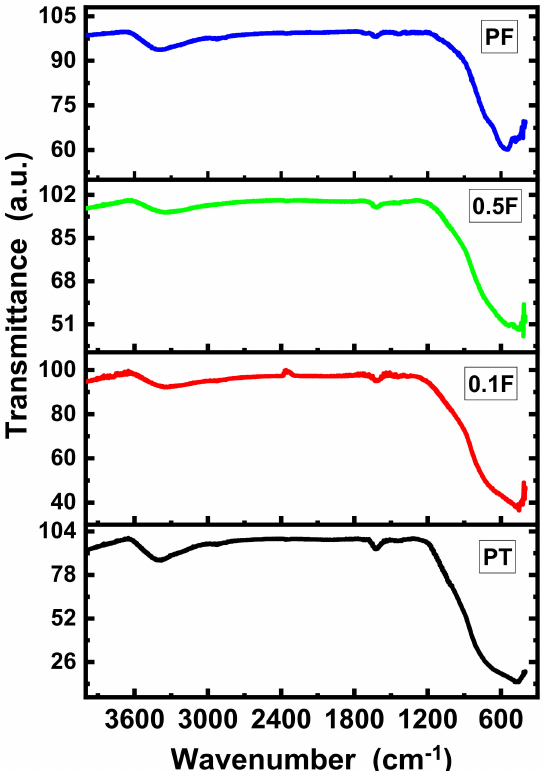
Figure 4. IR transmittance spectra for (TiO 2 ) 1 − x (Fe 2 O 3 ) x nanoparticles.